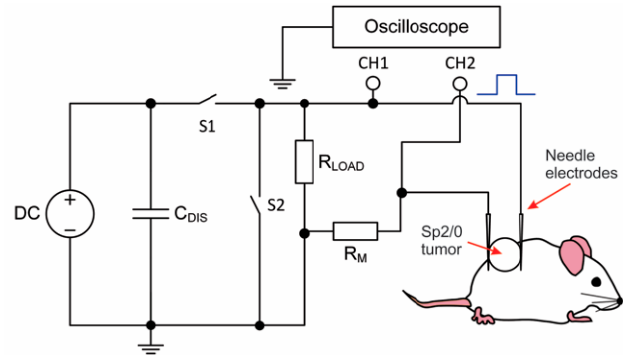
Figure 1. Experimental setup for the electrochemotherapy of tumors, where DC—direct current source, C DIS —discharge capacitance, S1 / S2 represent the switches, the R LOAD and R M are the load shunting and measurement resistances, respectively; CH1 and CH2—measurement channels of the oscilloscope. As a tumor model Sp2 / 0 cell line was used, while the pulses were delivered via invasive needle electrodes to neglect the influence of skin bioimpedance on the treatment